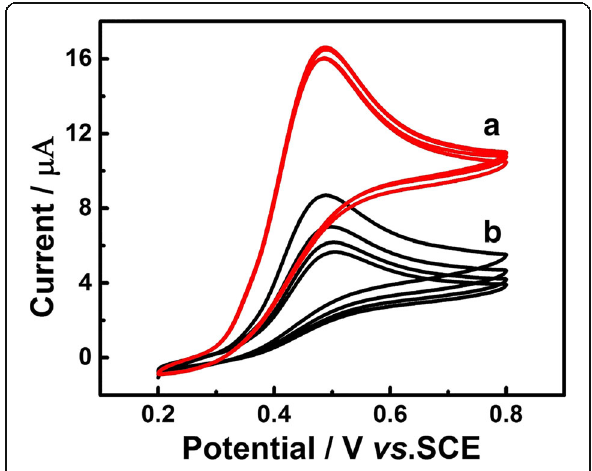
Fig. 2 CVs of Au/GCE in 0.1 M PBS (pH 7.0) solution containing 1.0 mM UA with (a) and without (b) visible light illumination.